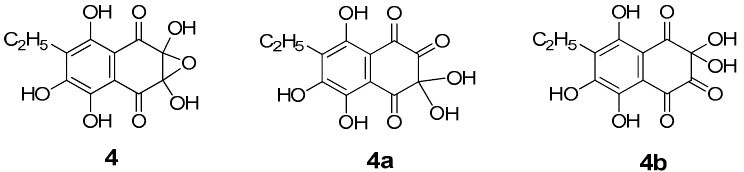
Figure 4. Structures of Ech A oxidation products with brutto-formula C 12 H 10 O 8 .